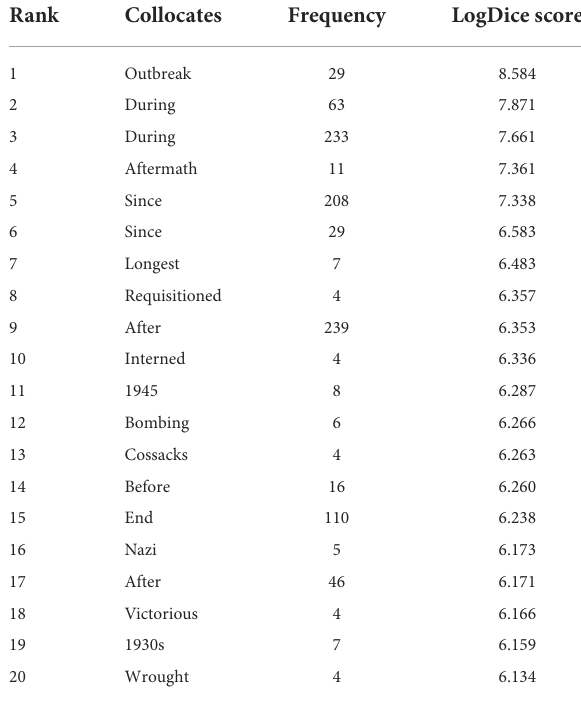
TABLE 7 The collocates of the second world war within a four-word span. Rank Collocates Frequency LogDice score 1